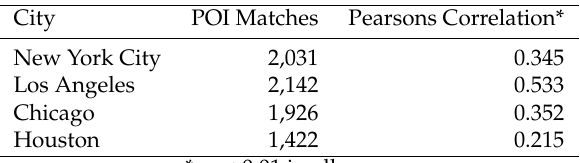
Table 2: Number of POI matches identified between SafeGraph Core Places and Google Places. Pearson’s correlation is reported between a change in SafeGraph’s Median Dwell Time and a change in Google Place’s Visit Duration from January 2020 to January